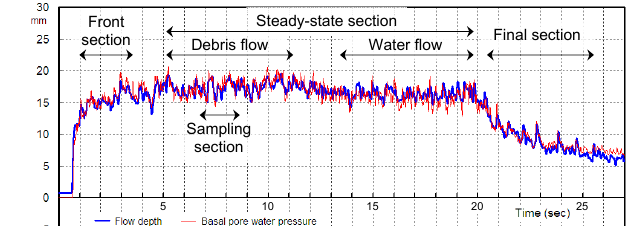
Fig. 5 Time series of flow depth and interstitial water pressure for a particle diameter of 1.3 mm, channel slope of 13 degree, and water supply of 2 L/s. The front, steady-state (debris flow and water flow parts), final, and sampling sections are shown.